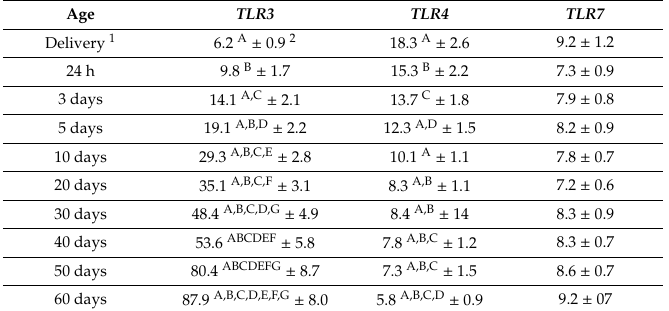
Table 2. Expression of TLR3 , TLR4 , and TLR7 mRNA over the foals’ subsequent days of age from the control group (mean ± standard error (SE).